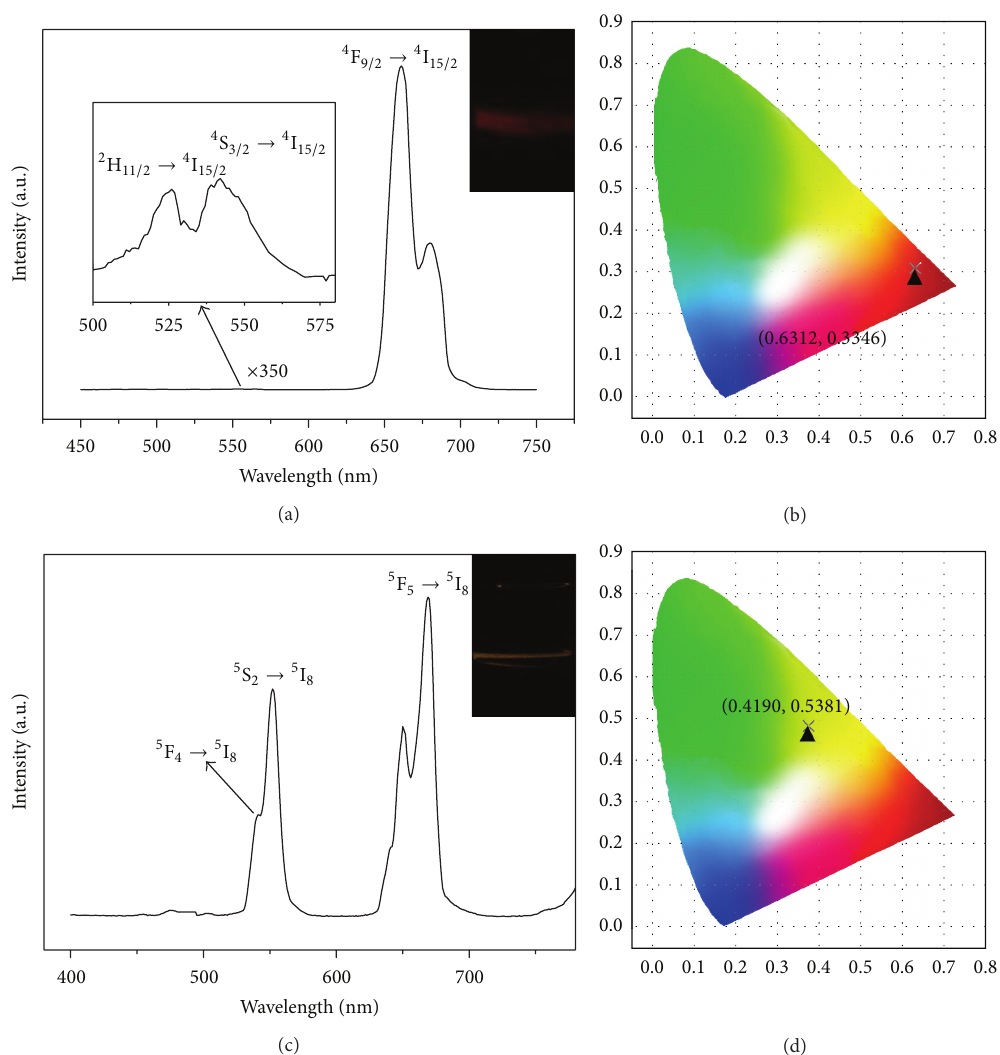
Figure 3: (a) UC spectra of Lu 2 O 3 :Yb/Er, (b) CIE chromaticity coordinates diagram of Lu 2 O 3 :Yb/Er, (c) UC spectra of Lu 2 O 3 :Yb/Ho, and (d) CIE chromaticity coordinates diagram of Lu 2 O 3 :Yb/Ho; the right insets of (a) and (c) are the corresponding digital photographs of 1wt% water soluble of the